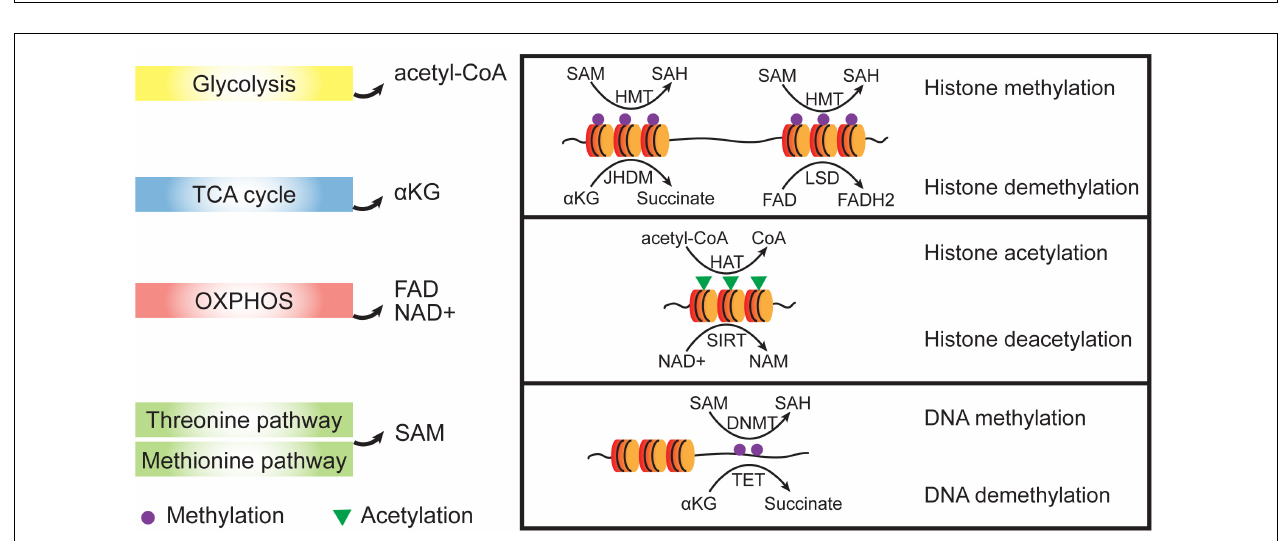
FIGURE 2 | Regulation of EMT–MET during reprogramming. Induced pluripotent stem cells (iPSCs) can be accelerated by sequential EMT–MET process. Early EMT can be induced by sequential expression of Yamanaka factors, adding TGF- β or inhibiting of LSD1. These treatments up-regulation of EMT-TFs and also proved metabolic switch from OXPHOS to Glycolysis (OGS). EMT and OGS coordinate to facilitate the reprogramming through an epigenetic regulation way.